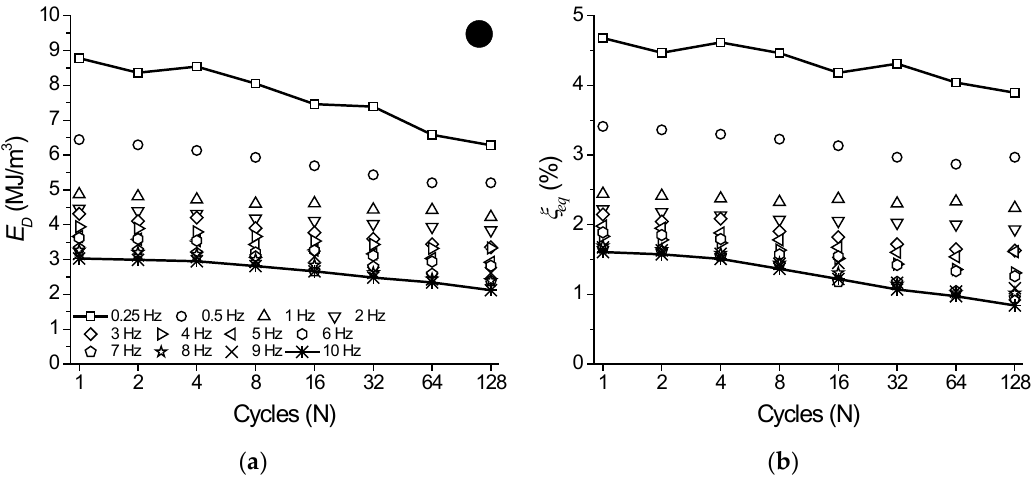
Figure 13. Functional properties variation with cycling as a function of the loading frequencies for the reference element. ( a ) Dissipated energy. ( b ) Equivalent viscous damping factor. with cycle number for each analyzed frequency. 𝜉